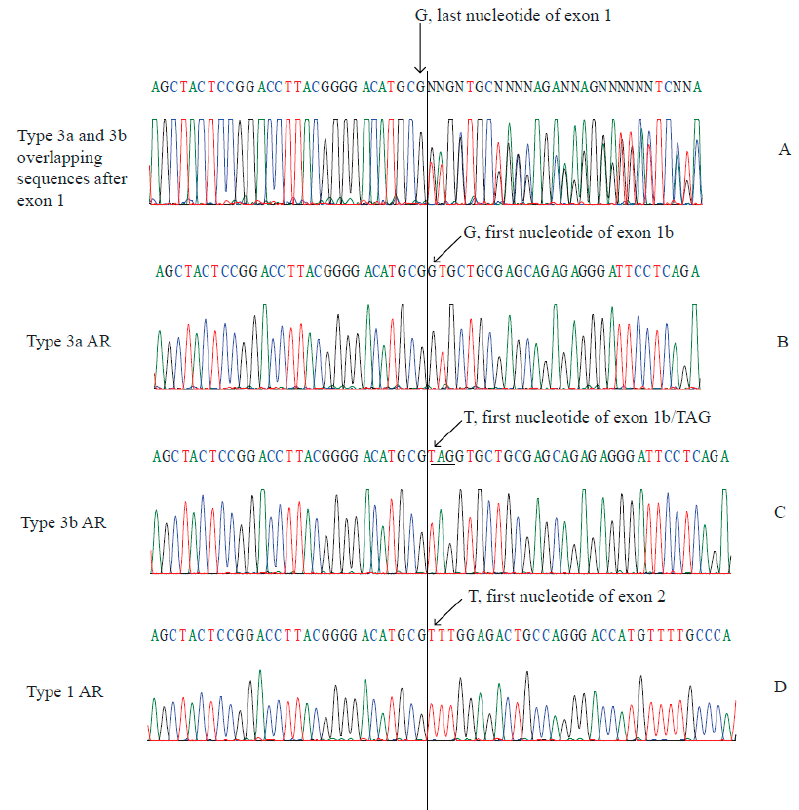
Figure 2. Chromatograms showing the sequences of RT-PCR amplicons spanning the exon 1/exon 1b region of type 3 AR transcripts (generated from VCaP cells): ( A ) direct sequencing of RT-PCR products showed two overlapping sequences after exon 1; ( B , C ) cloning of RT-PCR products followed by sequencing showed two different exon 1bs that generate type 3a (exon 1b) ( B ) and type 3b (exon 1b/TAG) ( C ) AR transcripts; and ( D ) sequence of the exon 1/exon 2 junction from wild-type AR transcripts (type 1 AR) for comparison. The nucleotides of A, C, G, T in chromatograms are in green, blue, black, and red, respectively. The curved line defines the junction between exon 1 and exon1b/exon1b/TAG (A), exon 1b ( B ), exon 1b/TAG ( C ), or exon 2 ( D ).